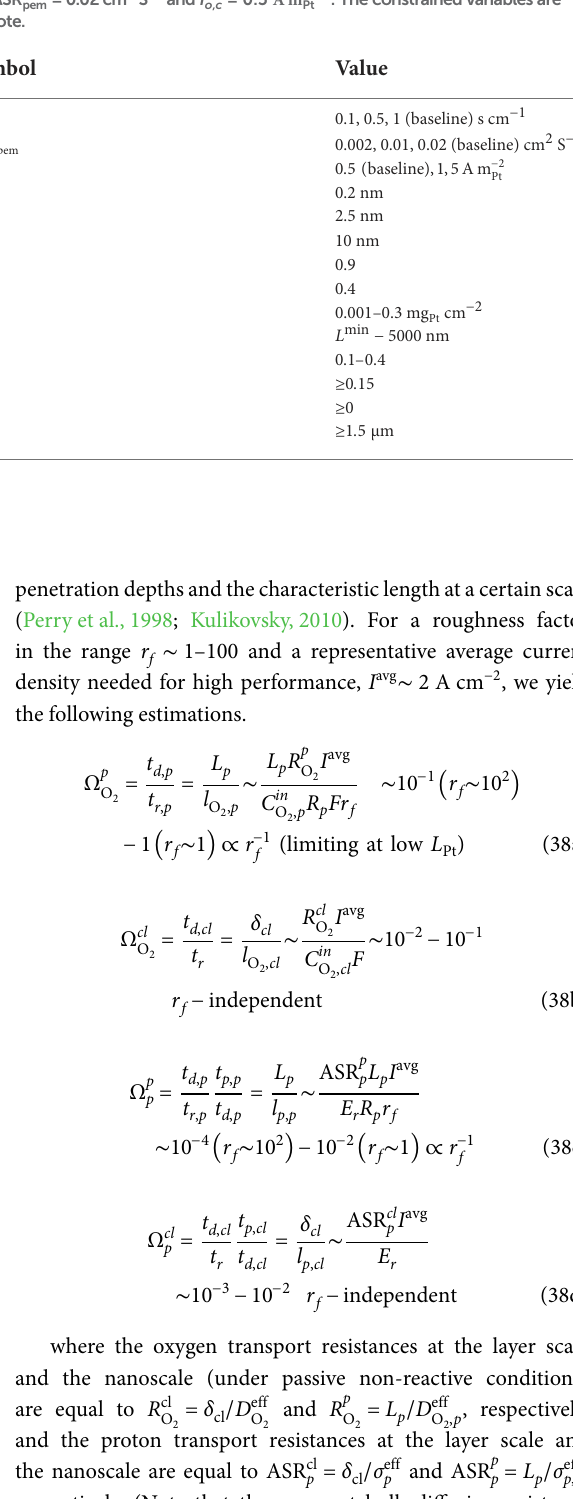
= 1 scm − 1 ,ASR pem = 0.02 cm 2 S − 1 and i o , c = 0 . 5 Am Pt − 2 .Theconstrainedvariablesare O 2